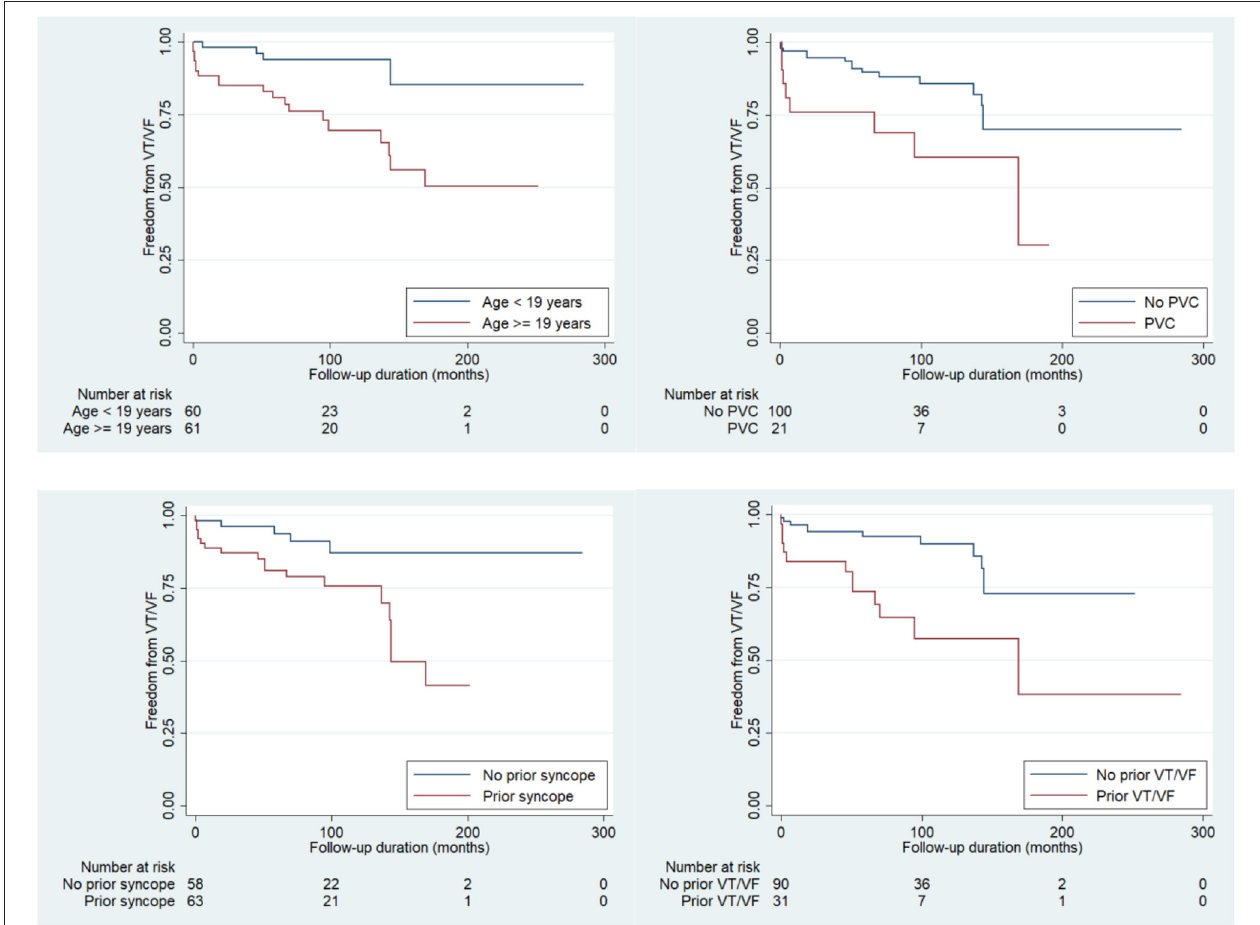
FIGURE 1 | Kaplan-Meier survival curves demonstrating freedom from spontaneous ventricular tachycardia/ventricular fibrillation (VT/VF) during follow-up stratified by age ≥ 19 years of age (top left ), PVC (top right ), initial presentation with syncope (bottom left ), initial presentation with VT/VF (bottom right ). All showed significant difference between the two groups by the log-rank